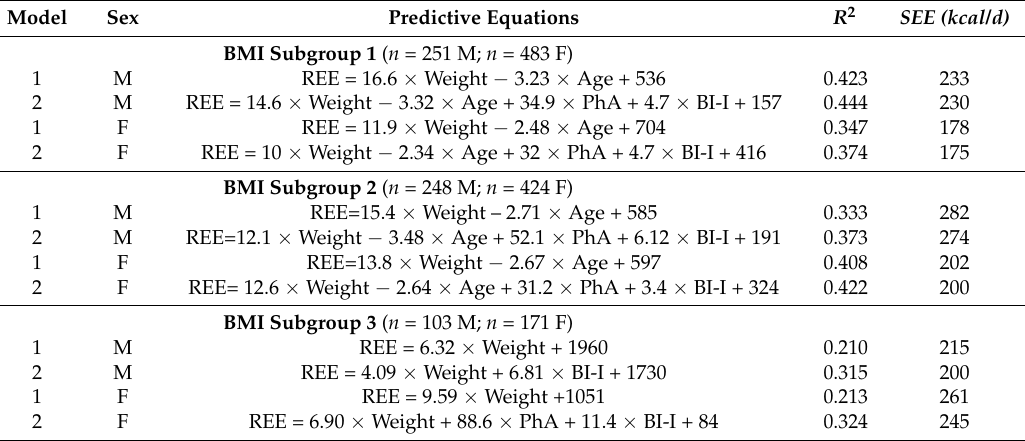
Table 4. New predictive equations based on model 1 or 2 in each BMI